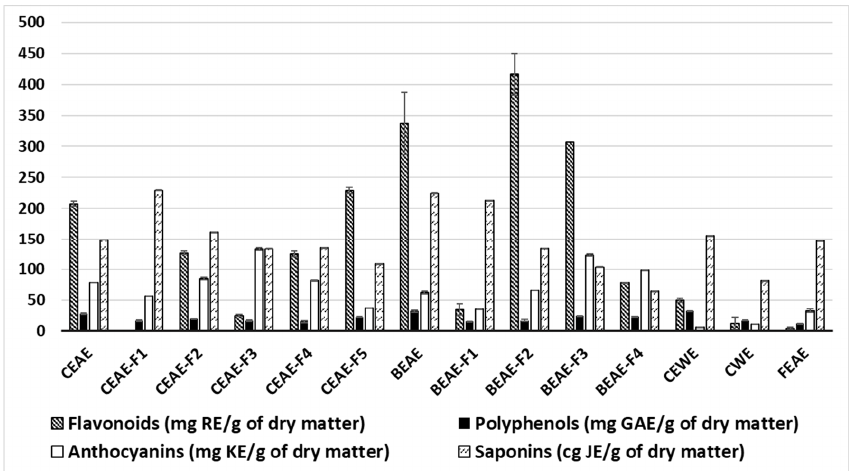
Figure 1. Flavonoid, polyphenol, anthocyanin and saponin levels of the different extracts determined by colorimetric methods. C. inophyllum aqueous extract = CWE, ethyl acetate extract = CEAE. B. pilosa ethyl acetate extract = BEAE and F. berteroana ethyl acetate extract = FEAE. CEAE-F1 to CEAE-F5 = fractions obtained from CEAE and BEAE-F1 to BEAE-F4 = fractions obtained from BEAE. RE = rutin equivalents, GAE = gallic acid equivalents, KE = kuromanin equivalents and JE = jujuboside equivalent.